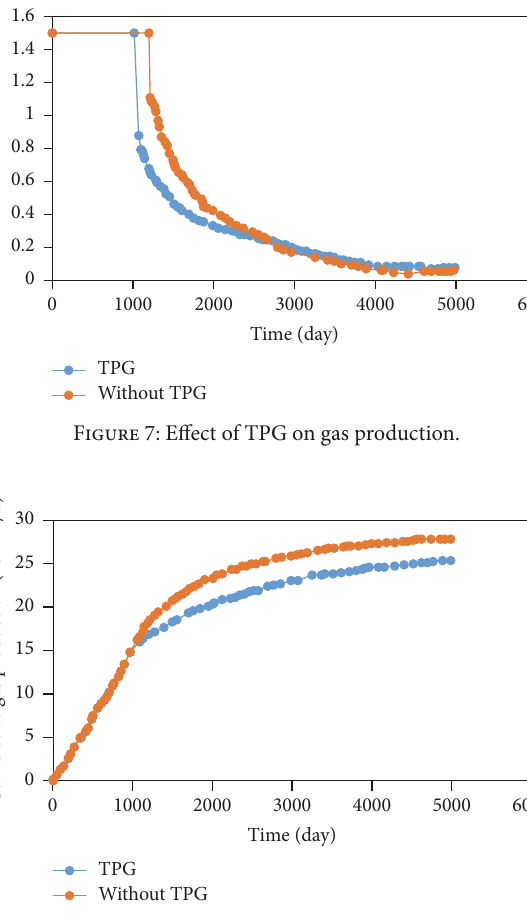
Figure 10: Effect of stress sensitivity on gas